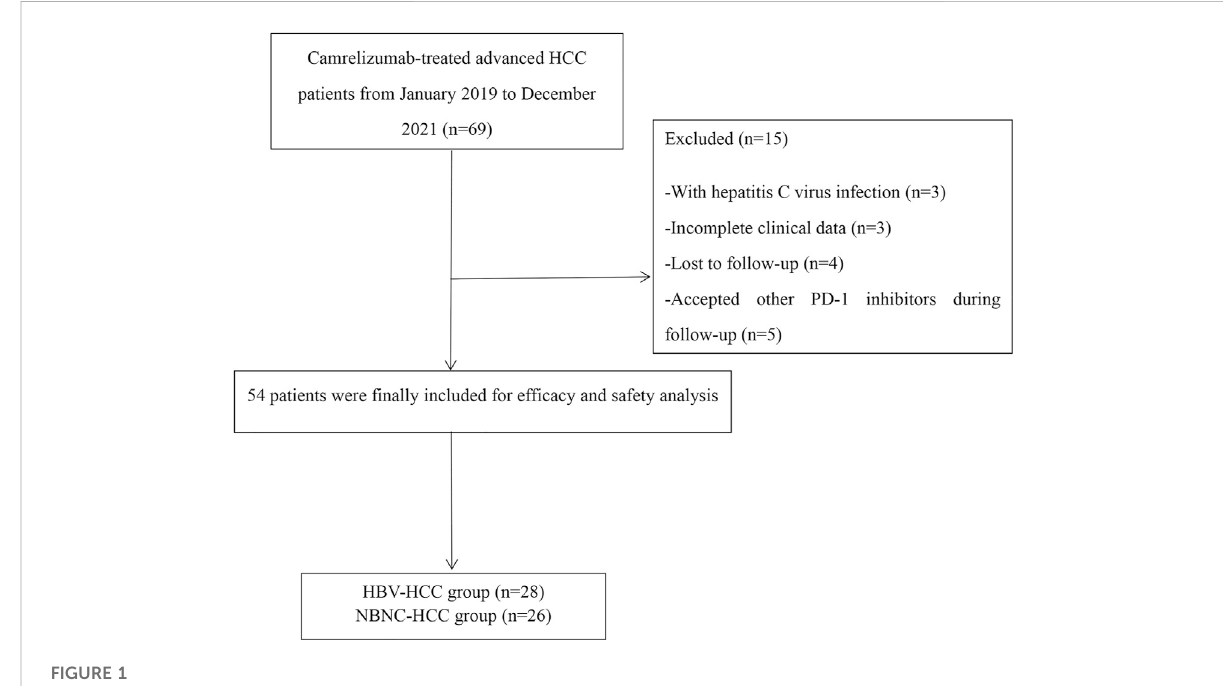
FIGURE 1 Patient fl